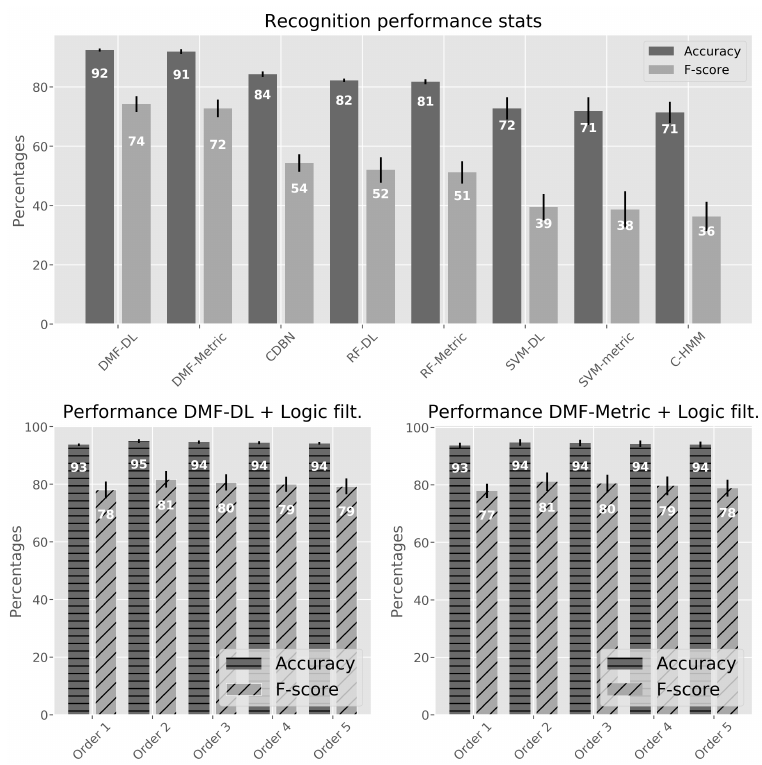
Figure 8. Performance statistics. Upper part: performance results (accuracy and F-score) for the methods in Table 1; Lower part: performance results for DMF-DL and DMF-Metric applying the logic filter with different